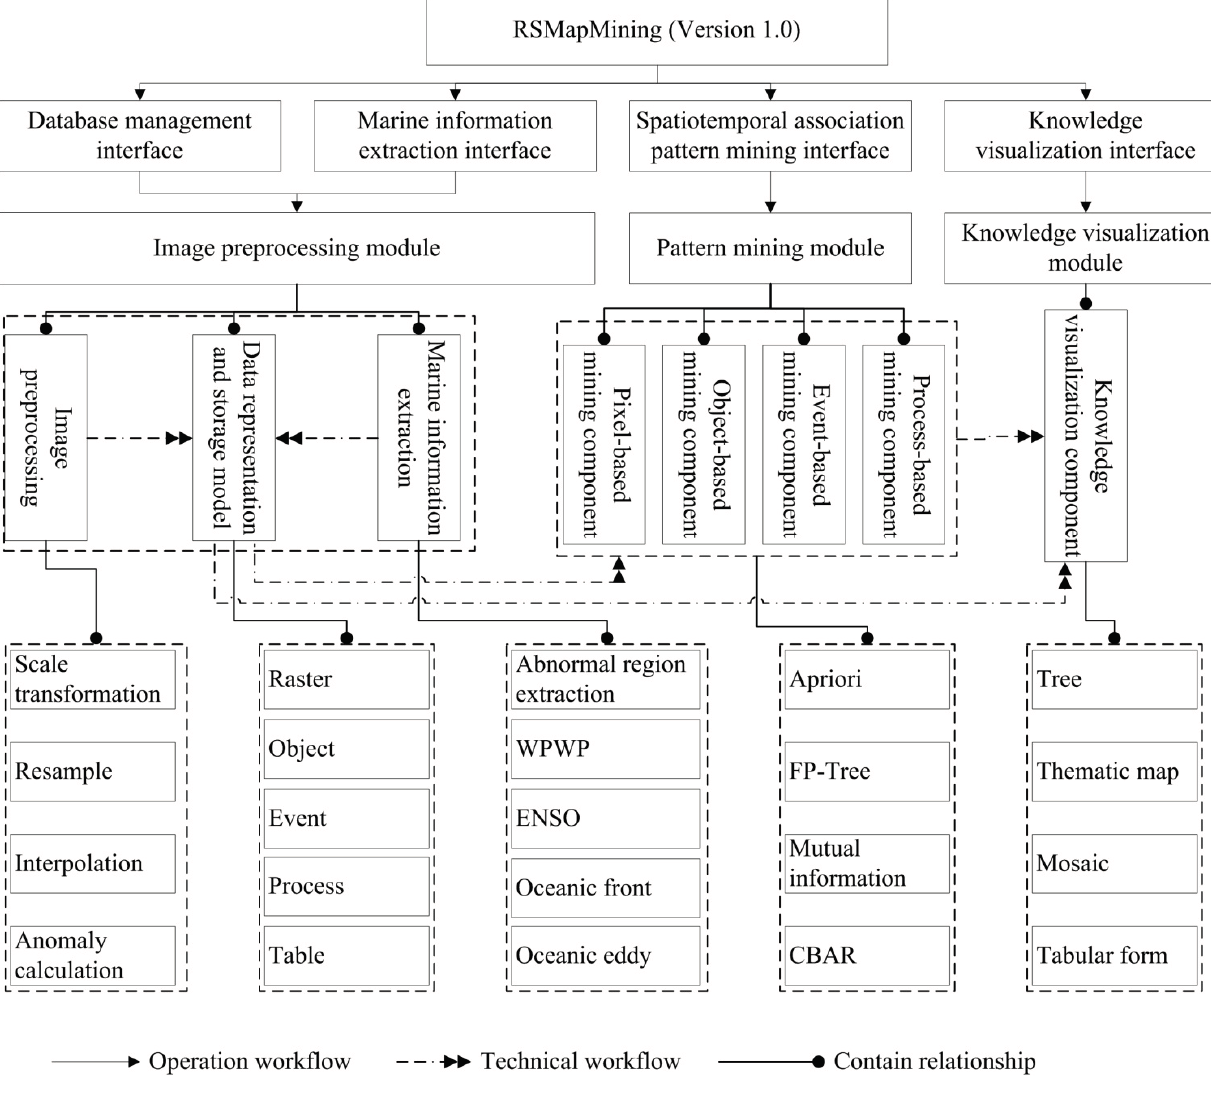
Figure 2. Workflow of